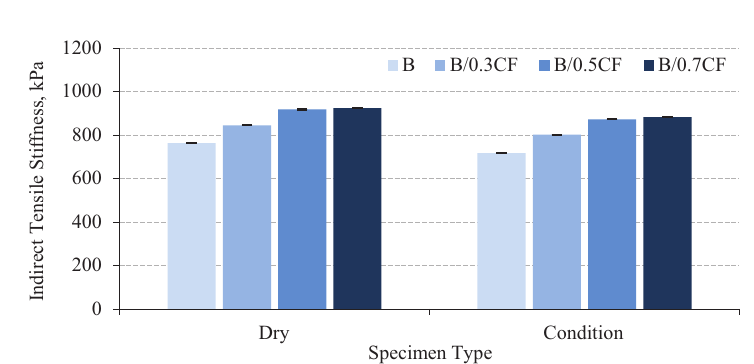
Figure 5. Indirect Tensile Stiffness values of the control and carbon fibre asphalt